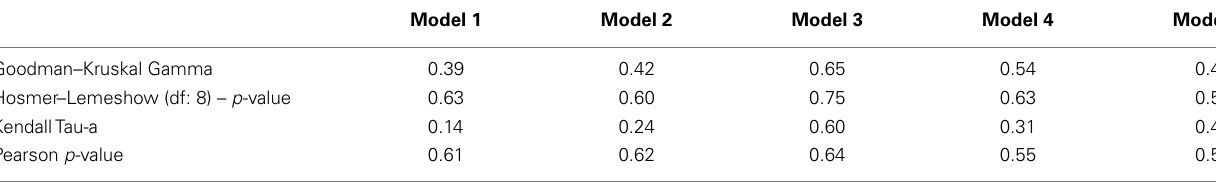
Table 2 | Model performance statistics based on binomial logistical regression analysis